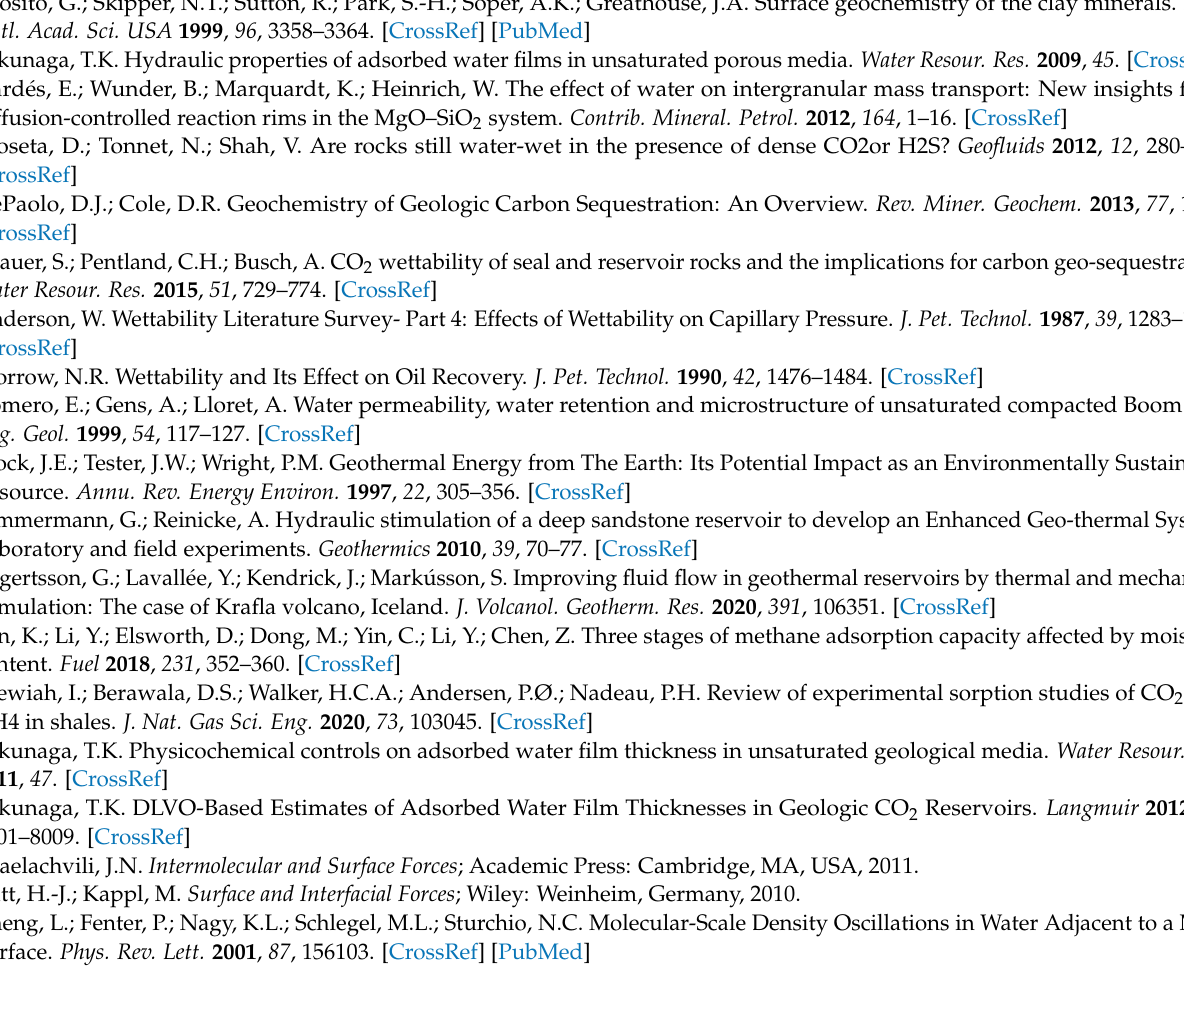
muscovite surface, Figure S5: Normalized density profiles of K + , O (H 2 O), and H (H 2 O), Figure S6: Schematic images of the lattice of (0 0 1) surface of muscovite, Figure S7: 2D normalized density maps of K + on the muscovite surface, Figure S8: Schematic image of one K + -site for calculating profiles of density and the orientation angle, Figure S9: Enlarged view of Figure 8c, Figure S10: Enlarged view of the part of Figure 10, Figure S11: Distributions of cos θ on K + -site and o-site at the second layer at 50 MPa, Figure S12: Schematic image of the definition of hydrogen bond, Figure S13: Self-diffusion coefficient of H 2 O molecules vs distance from the muscovite